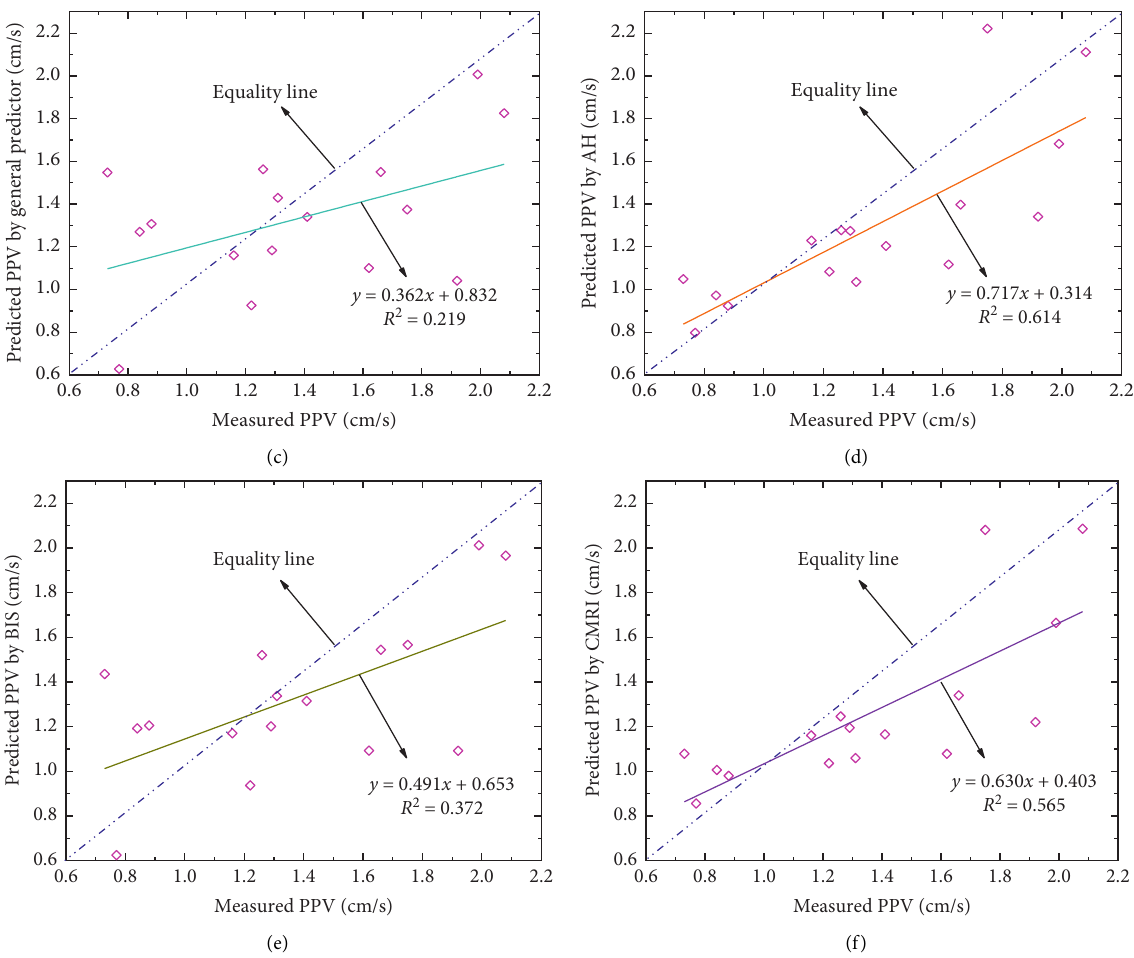
Figure 6: Relationship between measured and predicted PPV by USBM (a), LK (b), general predict (c), AH (d), BIS (e), and CMRI (f). (a) Relationship between measured and predicted PPV by USBM. (b) Relationship between measured and predicted PPV by LK. (c) Rela- tionship between measured and predicted PPV by general predict. (d) Relationship between measured and predicted PPV by AH. (e) Relationship between measured and predicted PPV by BIS. (f) Relationship between measured and predicted PPV by